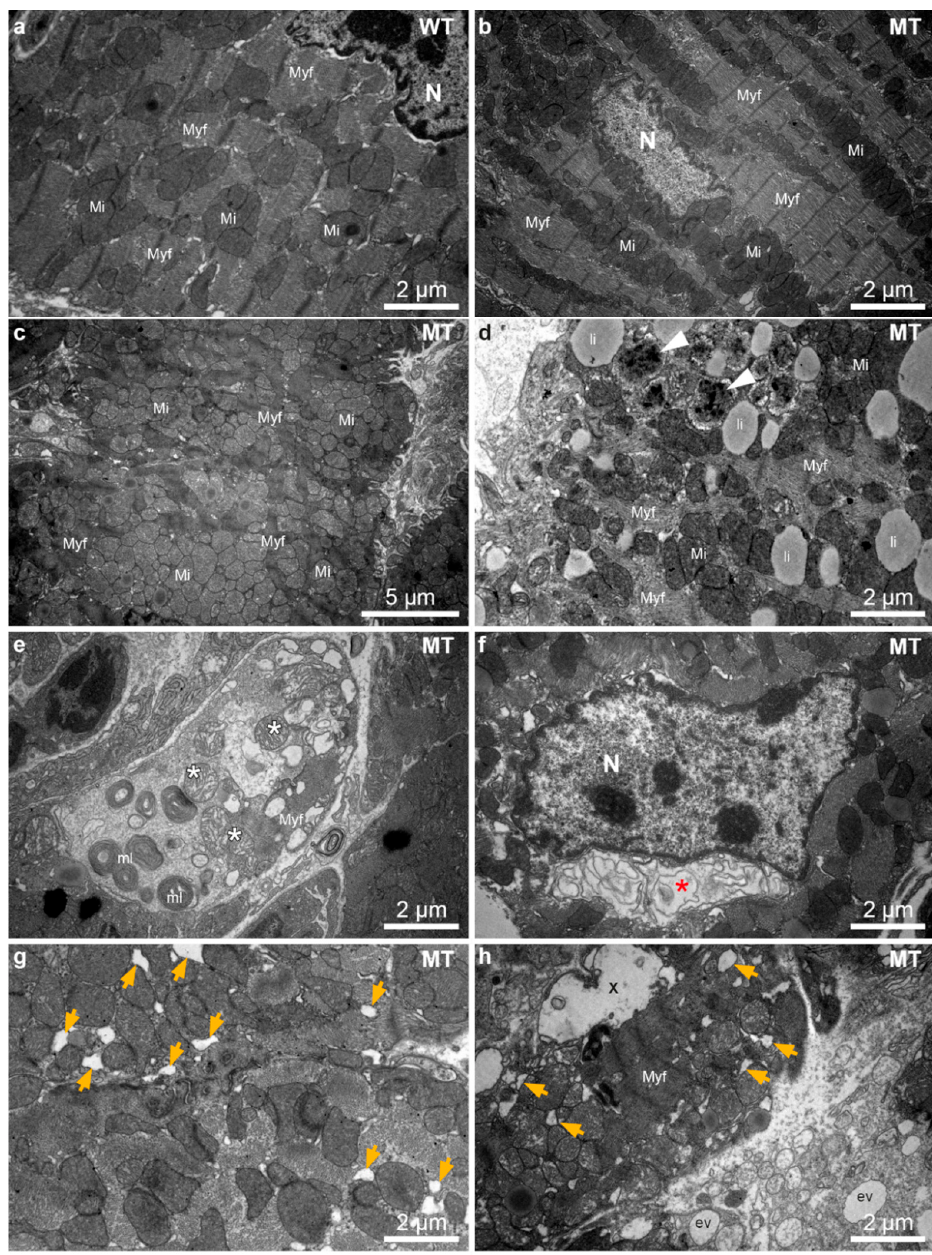
Figure 4. Dsg2 MT (MT) hearts contain numerous cardiomyocytes with architectural disorders, multilamellar bodies and autophagosomes at structural disease onset (2–3 weeks). ( a – e , g , h ) show micrographs from the left and ( f ) a micrograph from the right ventricle. ( a ) shows an electron micrograph of a typical wild-type (WT) cardiomyocyte. Mi, mitochondrium; Myf, myofibril; N, nucleus. ( b ) shows the ultrastructure of a normal-appearing cardiomyocyte of a Dsg2 MT (MT) mouse. A considerable number of cardiomyocytes, however, present abnormalities such as mitochondrial clustering, myofibrillar misalignment and degeneration ( c , d ). Autophagic vacuoles (white arrowheads, ( d )) and multilamellar bodies (mL, ( e )) are also detectable in the Dsg2 MT myocardium. Lipid droplets (li) are found in mutant and wild-type cardiomyocytes. An extensive myofibril-free region of a cardiomyocyte and mitochondria with rarefied cristae (*) of a Dsg2 MT hearts are shown ( e ). An enlarged, membrane-containing perinuclear space (*) is shown in ( f ). It is indicative of autosis. Dilated ER/SR cisternae ae observed in cardiomyocytes of Dsg2 MT mice (orange arrows in ( g , h )). Furthermore, cardiomyocytes containing empty ballooned structures (X) and areas with amorphous cytoplasm and empty vacuoles (ev) are detectable ( h ).